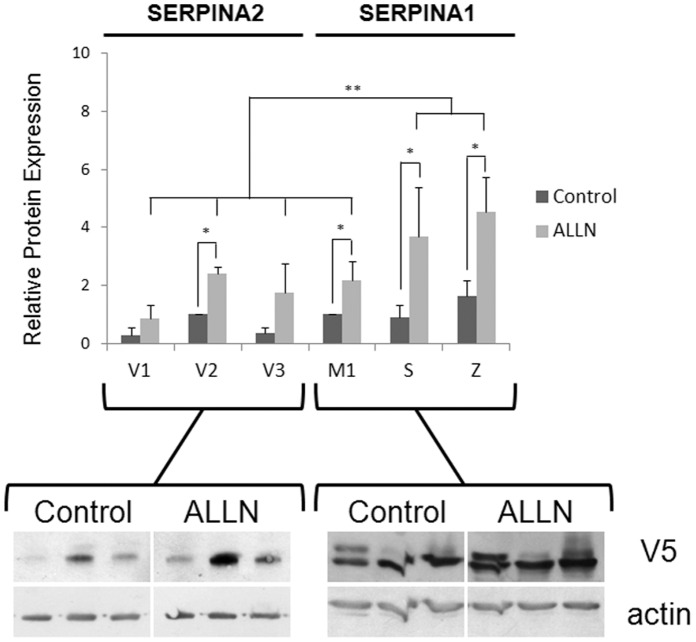
Analysis of the impact of proteasome inhibition in SERPINA2 and SERPINA1 expression.HeLa cells stably expressing SERPINA2 and A1 were treated with ALLN (50 µg/mL). Samples were subjected to 10% SDS-PAGE and immunoblotted for V5 tag. Actin was used as loading control. Relative protein expression was quantified through band intensity and presented graphically; n = 3, mean+SD; *p<0.05; **p<0.01.